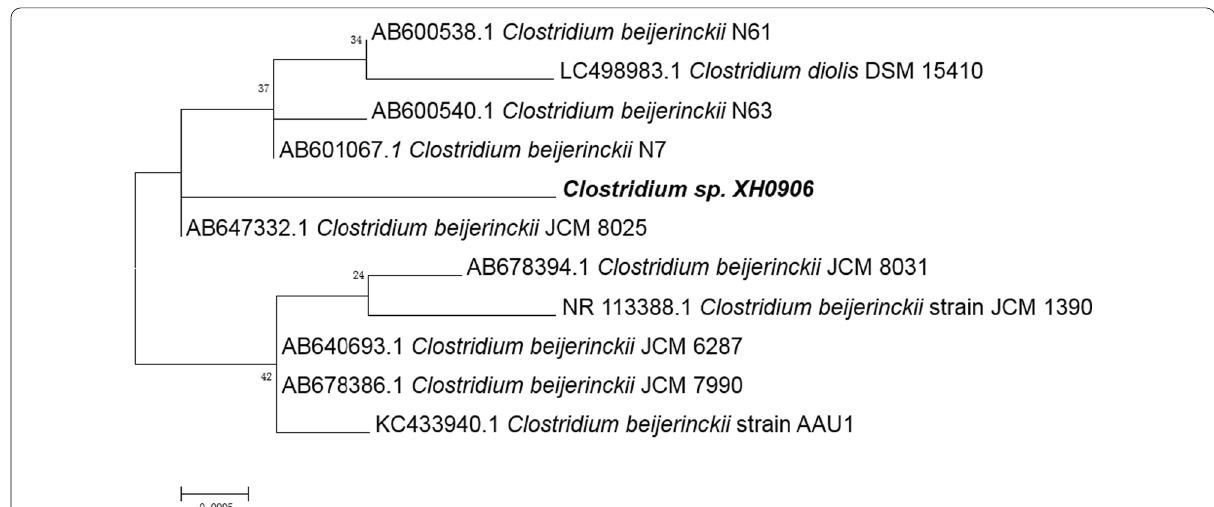
Fig. 1 Phylogenetic tree of Clostridium beijerinckii XH0906 and closely related strains according to 16S rRNA gene